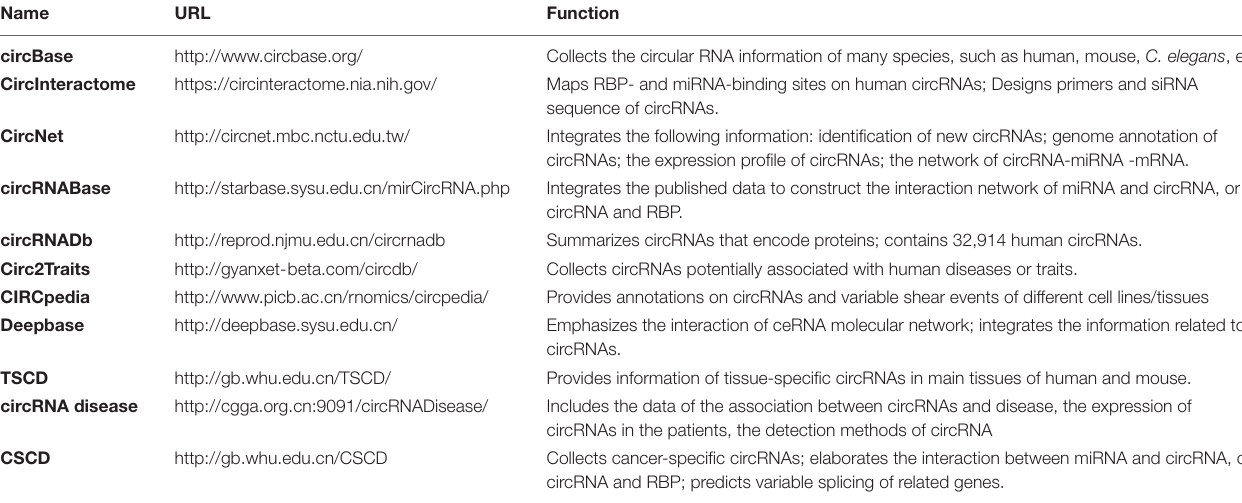
TABLE 1 | Database for circRNA